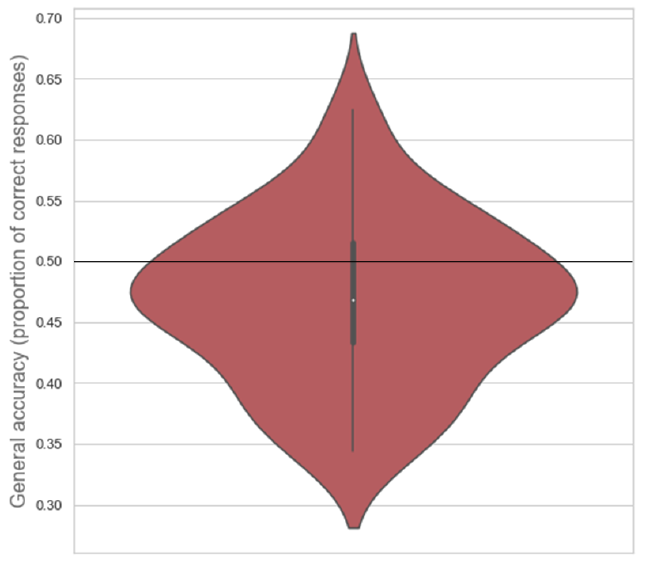
Figure 8. Violin plot of the distribution of general accuracy scores with median (white dot), 1.5 × interquartile range (grey vertical line), and chancel level (black horizontal line) indicated. Larger surface area indicates more scores at that